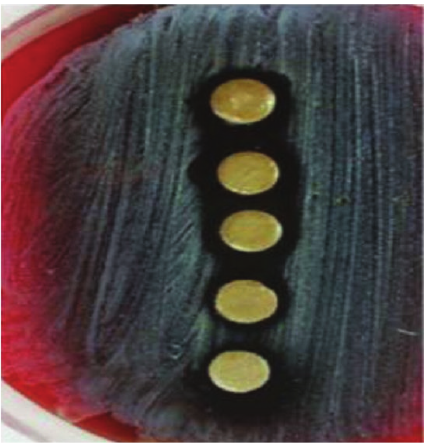
Figure2:Theeffectsofaqueousextractsofjuglansregiabarkagainst S. salivarius .